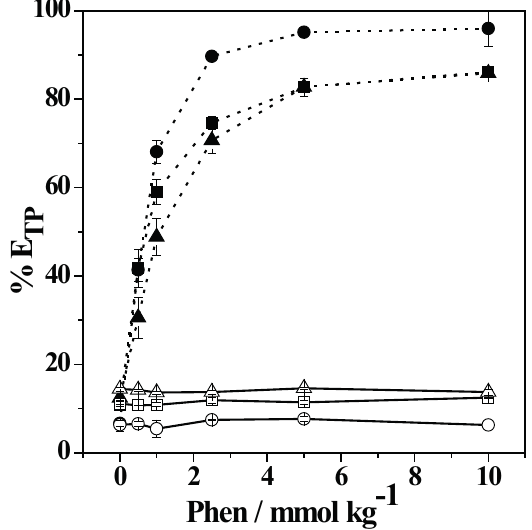
Figure 2 - Effect of pH and 1,10-phenatroline (phen) quantity added to PEO1500 + Na 3 C 6 H 5 O 7 + H 2 O ATPS on the %E TP of iron species: ( (cid:3) , (cid:4) ) pH 1.00; ( ◦ , • ) pH 6.00; ( D , (cid:78) ) pH 12.0; (full) Fe(II); (open) Fe(III); [iron]=0.100 mmol kg -1 ; T=25.0 °C;